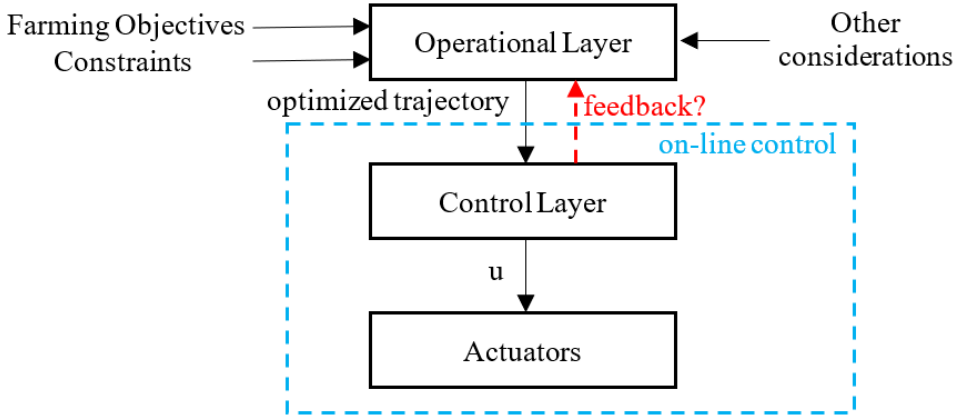
Figure 4. The hierarchical two-layer structure of agricultural machinery control.